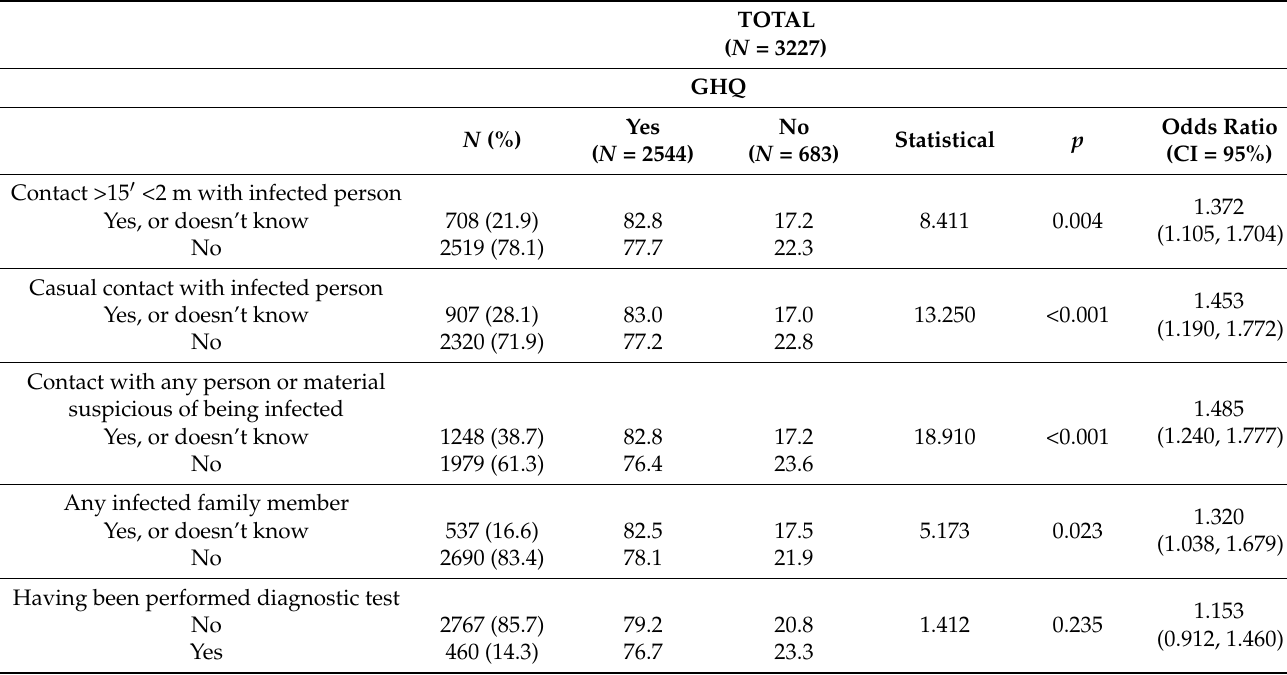
Table 4. Association between variables related with history of contact and psychological distress during the pandemic.